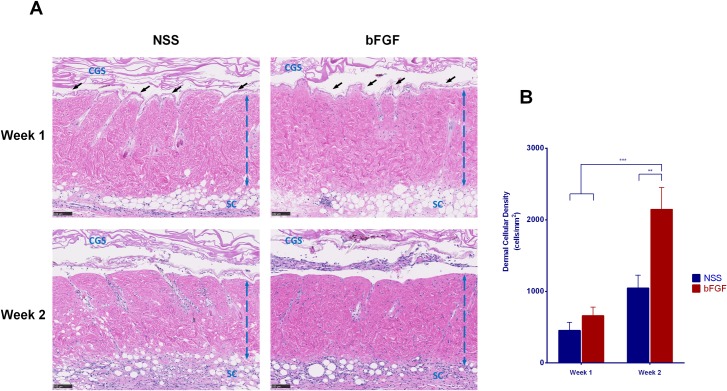
The infiltration of recipient cells into inactivated dermis after implantation.(A) Micrographs of HE-stained sections of skin grafts at Weeks 1 and 2 after implantation. The original dermal cell remnants were absorbed, and the epidermis indicated by black arrowheads was detached from the papillary dermis at Week 1. Cells from recipients showed infiltration to the dermis, and the dermal cellular density increased over the time. No inflammation reactions or dermal collagen fiber degeneration was observed. The blue broken lines indicate the dermis of grafts, CGS: collagen gelatin sponge after implantation, SC: subcutaneous layer; magnification: 10x, scale bar: 100 μm. (B) The diagram shows significant differences in the dermal cellular density of the bFGF group between Weeks 1 and 2 (*** p < 0.001); the dermal cellular density of the bFGF group at Week 2 was significantly higher than that in the NSS group (** p < 0.01).